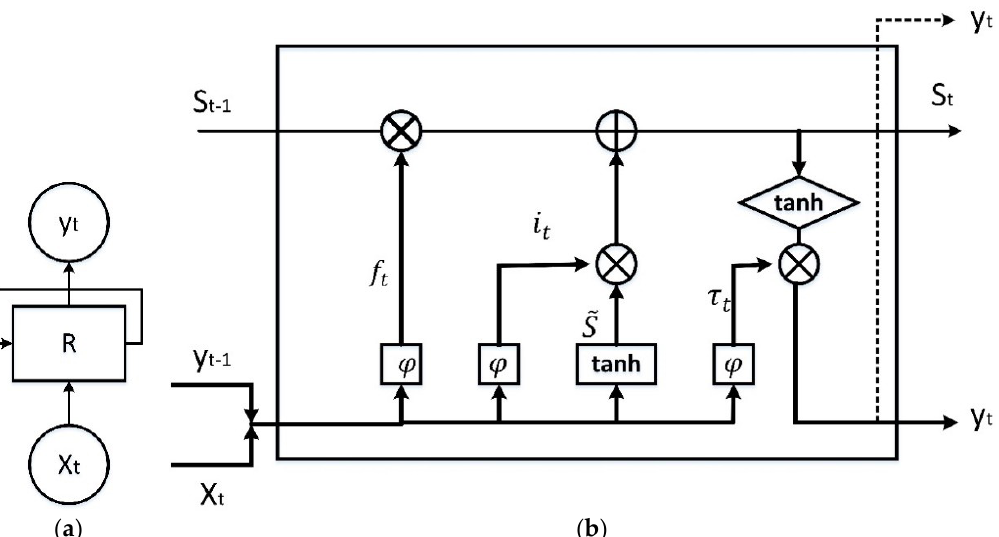
Figure 3. Schematic view of the recurrent neural networks (RNN) model—Long Short-Term Memory (LSTM) Method. ( a ) RNN loop; ( b ) inside of the LSTM module (regenerated from [24]) .